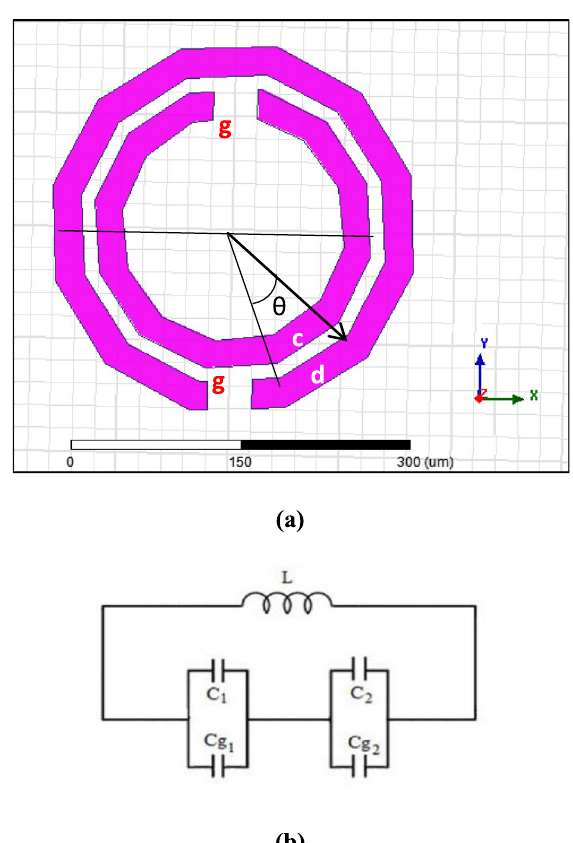
Fig. 1 Structure of dodecagon SRR. a Representation in rings. b Equivalent electrical circuit